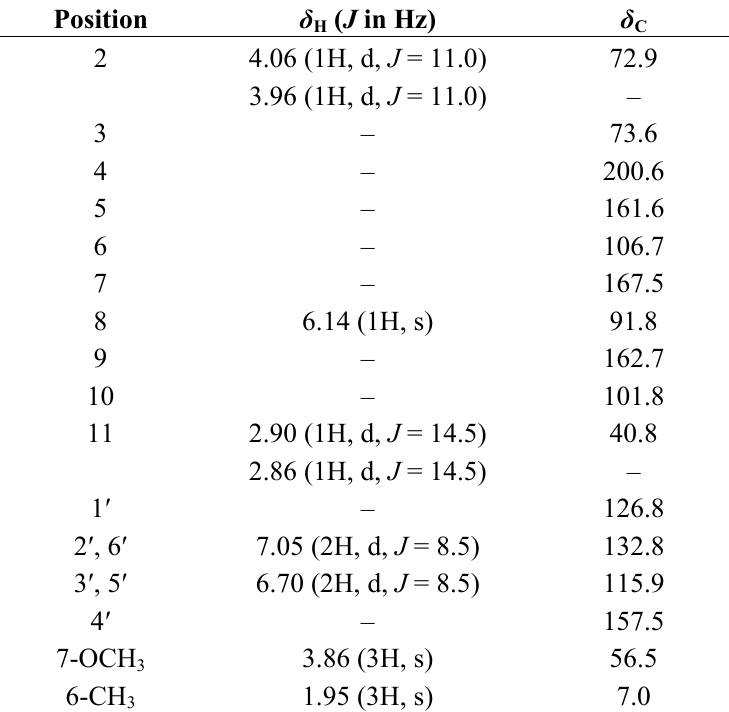
Table 2. 1 H-NMR (500 MHz) and 13 C-NMR (125 MHz) spectra data of compound 3 OD, J in Hz, δ in (in CD 3